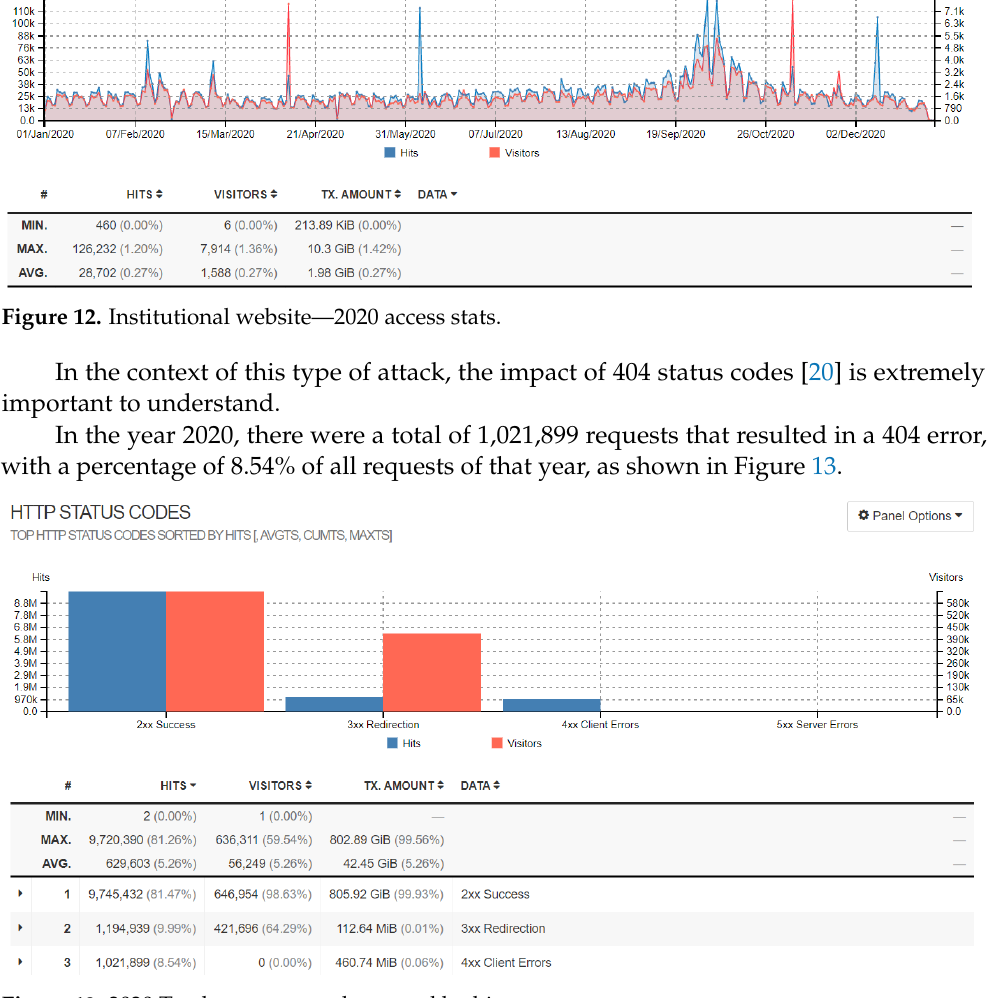
Figure 13. 2020 Top http status codes sorted by hits.